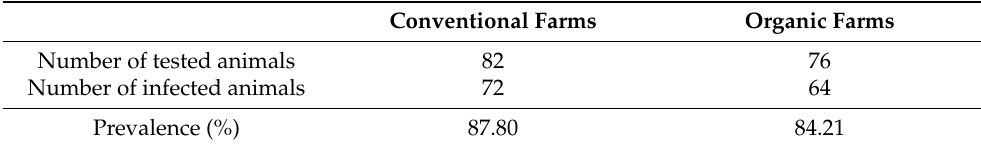
The mean prevalence of Eimeria spp. was 85.4% in conventional farms and 77.6% in